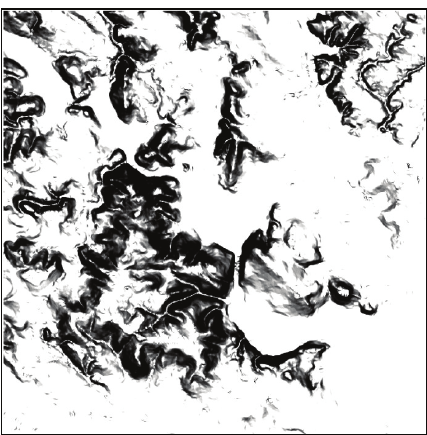
Figure 1: Visualization of calculation results of coefficient 𝐶 1 .